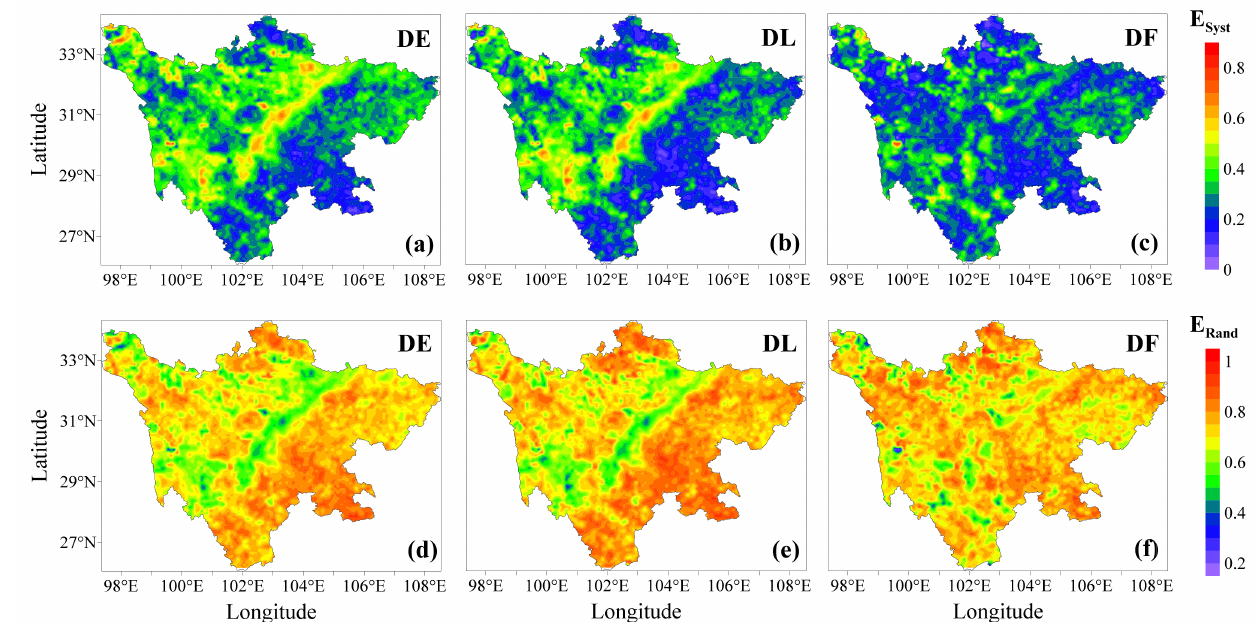
Figure 11. Spatial distributions of systematic errors (the first row, a – c ) and random errors (the second row, d – f ) in percentage form for the three IMERG estimates. From left to right, three columns represent IMERG-DE ( a , d ), DL ( b , e ), and DF ( c , f ), respectively.